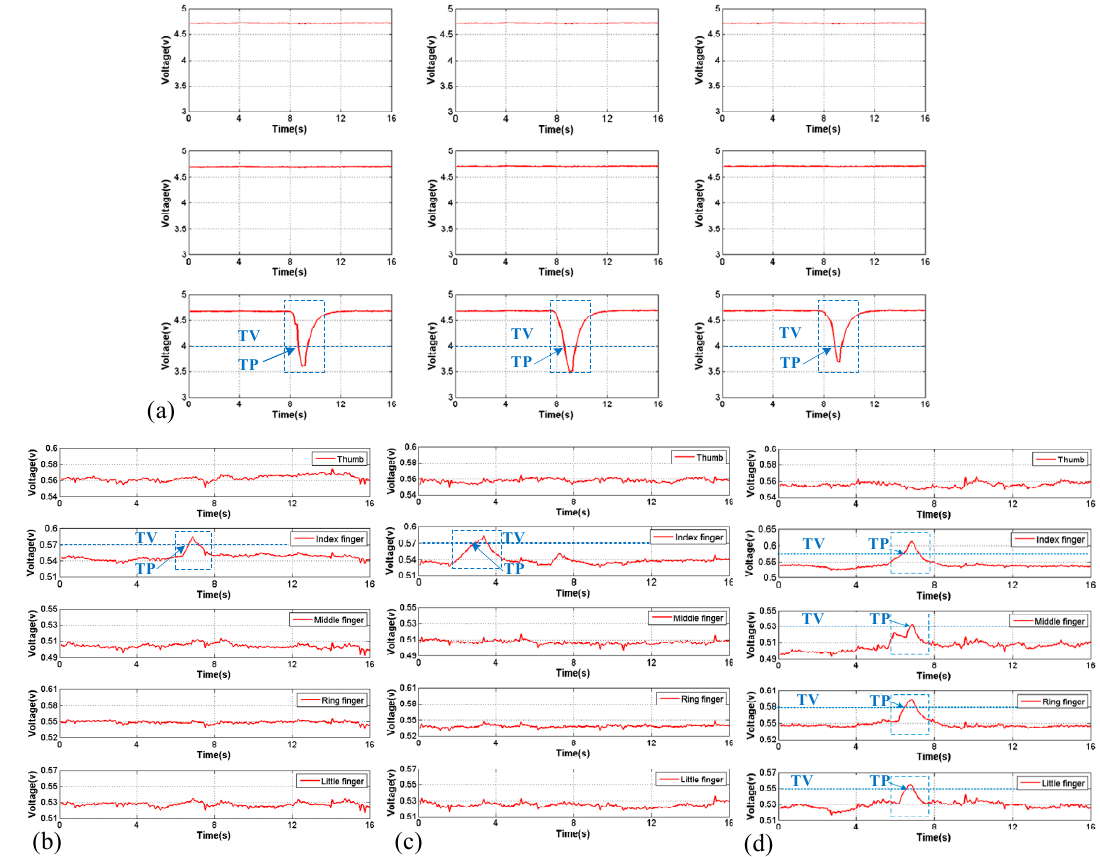
Figure 8. The trigger state detection of TDO. ( a ) Palm touch force trigger detection: plastic frame. ( b ) Index fingertip touch force trigger detection: roller ball pen. ( c ) Index fingertip touch force trigger detection: screwdriver. ( d ) Multiple fingertip touch force trigger detection: handshake.